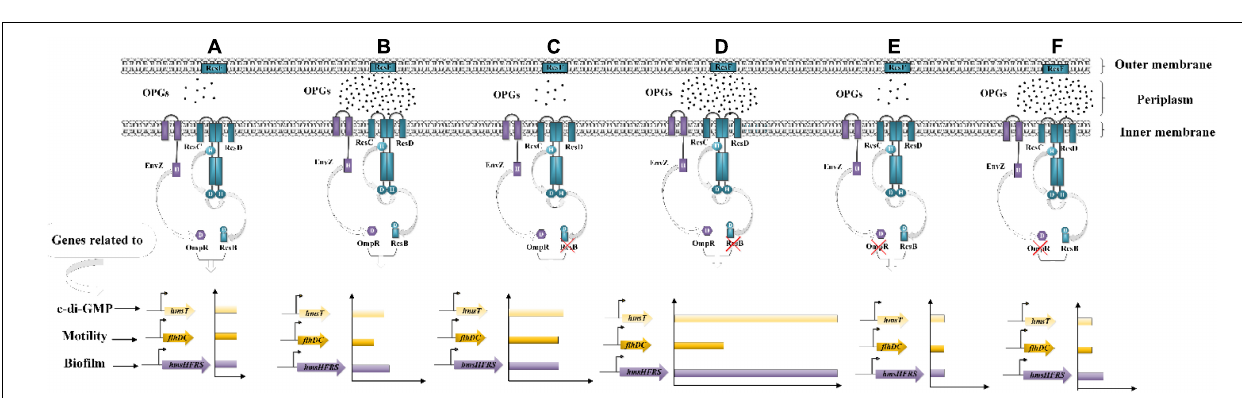
FIGURE 9 | Effects of Rcs and EnvZ/OmpR phosphorelays on OPGs-induced biofilm and c-di-GMP production in Y. enterocolitica . (A,B) OPGs overproduction induces the expression of hmsHFRS and hmsT , thus promoting biofilm and c-di-GMP production in the presence of both Rcs and EnvZ/OmpR phosphorelays. (C,D) Disruption of the Rcs phosphorelay upregulates the expression of flhDC , hmsHFRS and hmsT , resulting in increased motility and further promoted the induction of biofilm and c-di-GMP production regulated by OPGs. (E,F) Disruption of the EnvZ/OmpR phosphorelay decreases flhDC , hmsHFRS, and hmsT expression, inhibiting motility and preventing the induction of biofilm and c-di-GMP production regulated by